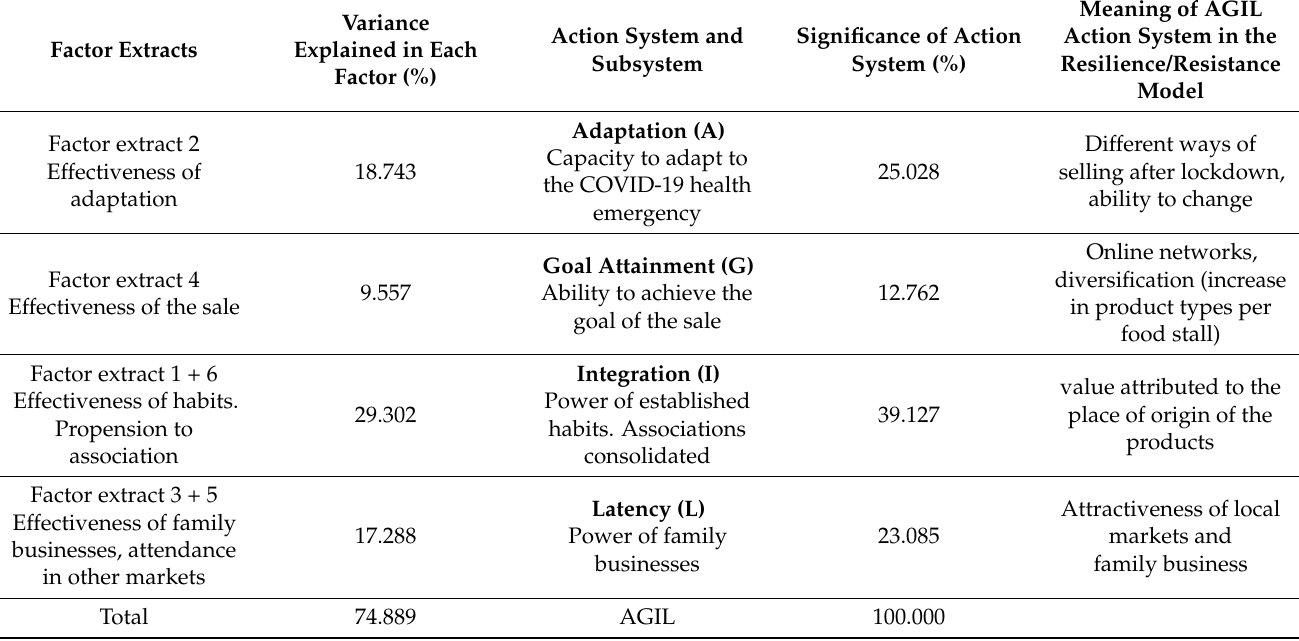
Table 5. Components extracted from the factor analysis, percentage variance from each component, action system and subsystem of the AGIL scheme relative weight of the components on the total and meaning of the AGIL action system in the resilience/resistance model of vendors to the health emergency from